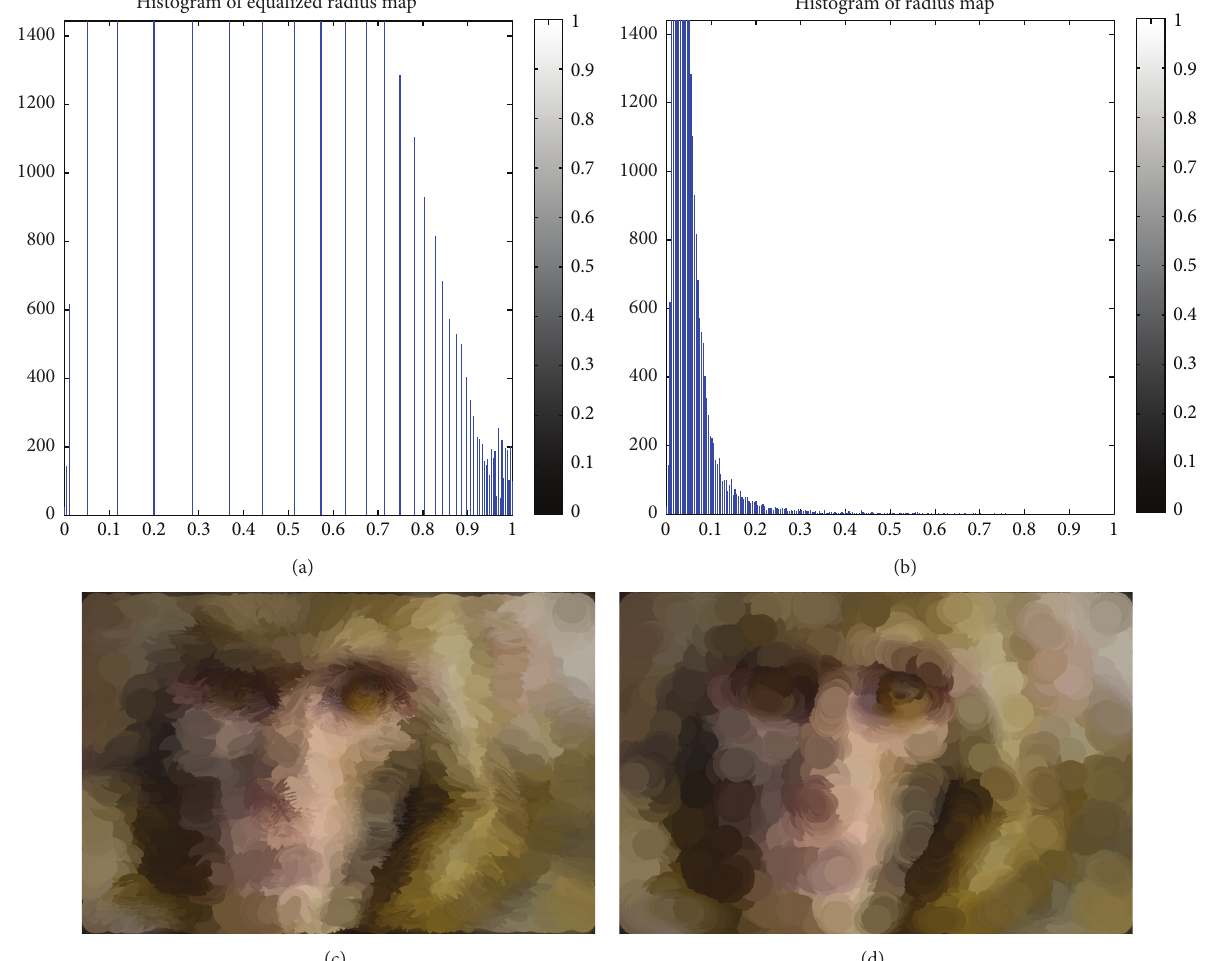
Figure 4: Comparisons of two Pointillisms with equalized/unequalized 𝑅 𝑆 Map, 𝑁 = 40000